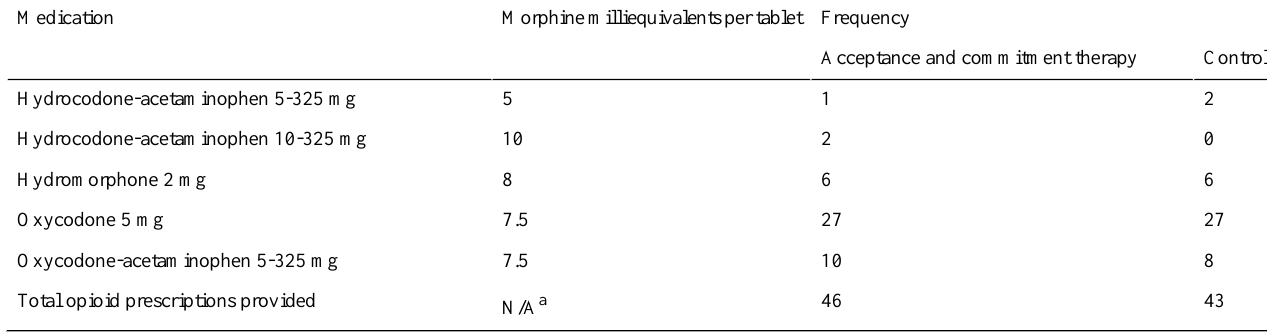
Table 4. Frequency of outpatient opioid pain medications prescribed by enrolled study group